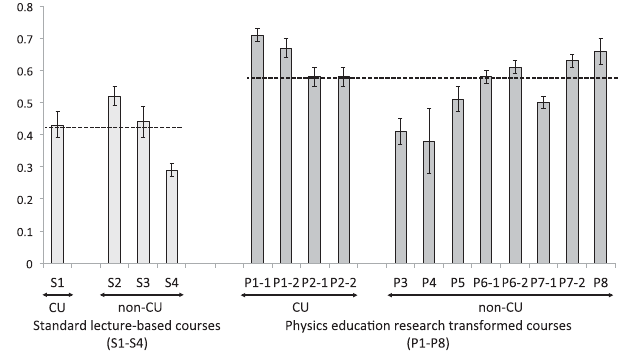
FIG. 5. CURrENT post-test scores across 9 institutions ( N ¼ 500 students); there were 4 standard lecture courses (S1 – S4) and 12 PER transformed courses (P1 – P8). Courses are not listed chronologically. Error bars represent the standard error of the mean; the two dashed lines represent averages across the two types of courses, either traditional or transformed (see Sec. VI C for